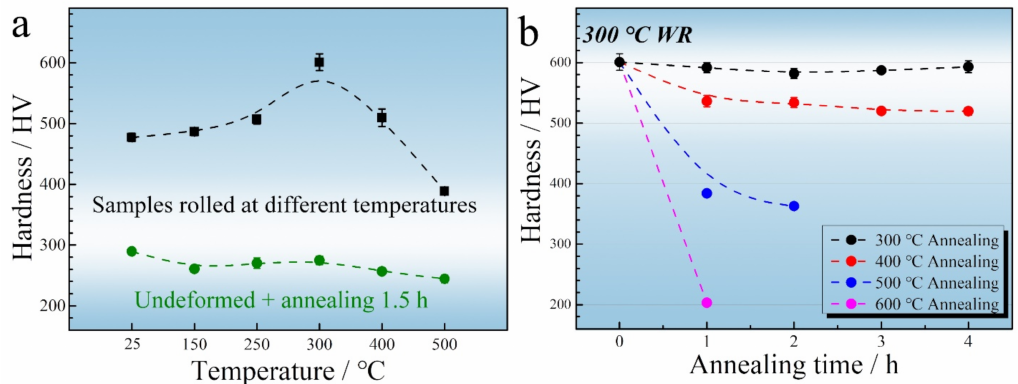
Figure 4. Evolution of the microhardness: ( a ) microhardness of the samples rolled at different temperatures with 85% thickness reduction and the undeformed samples annealed at different temperatures for 1.5 h, ( b ) microhardness of the warm-rolled sample (300 ◦ C) annealed at different temperatures.